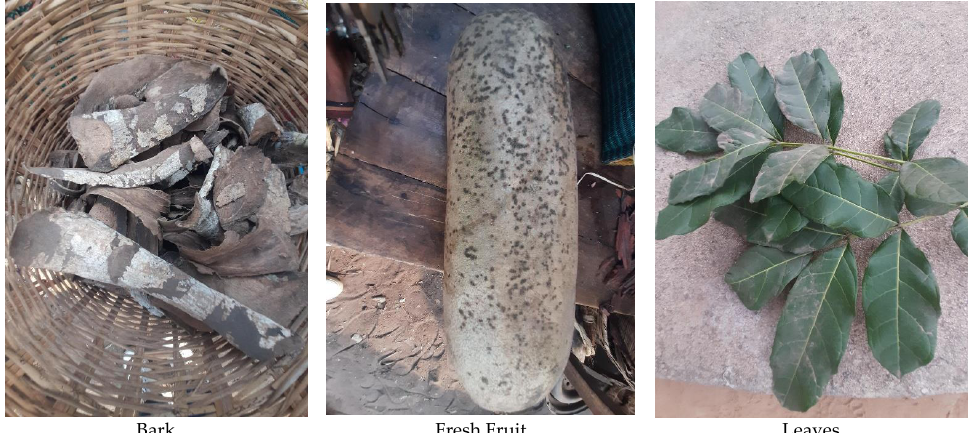
Figure 1. Different traded parts of K . africana plant.